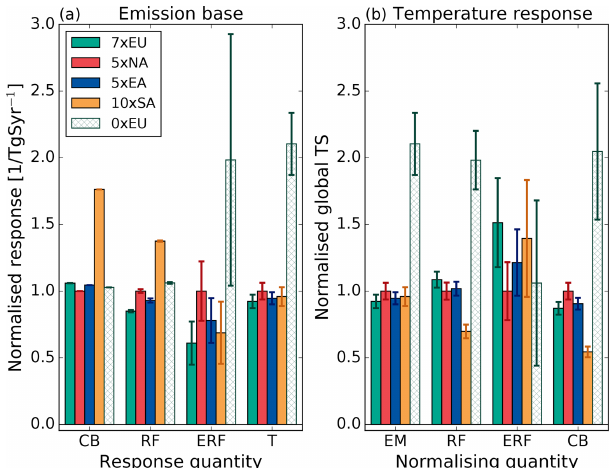
Figure 3. Normalised (a) column burden (CB), radiative forcing (RF), effective radiative forcing (ERF) and temperature ( T ) per unit SO 2 emission; and (b) normalised temperature response per emis- sions, RF, ERF and CB in the different experiments. Quantities are normalised by the 5 × NA response. The error bars show the stan- dard